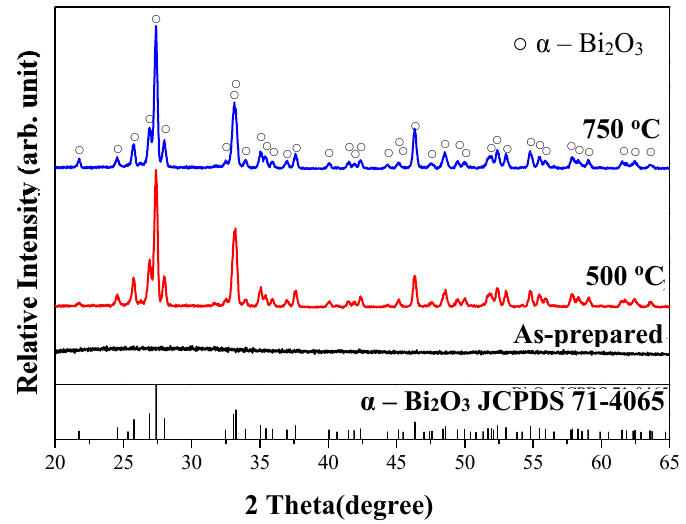
Figure 2. XRD patterns of as-obtained and heat-treated Bi 2 O 3 powders prepared using the sol-gel process.